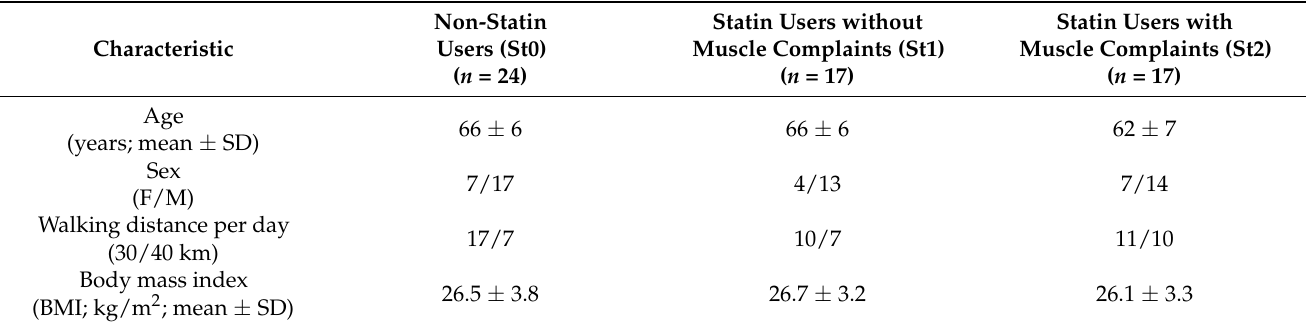
Table 2. Demographic data of the study